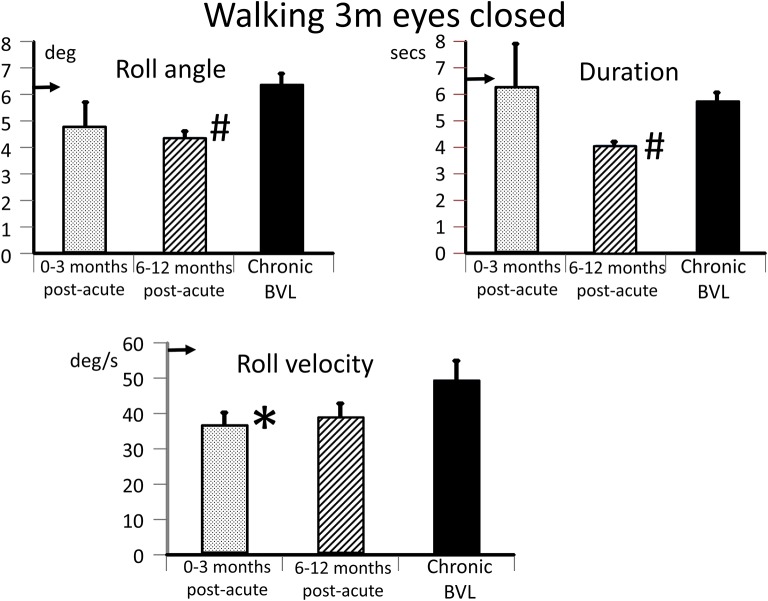
Measures of trunk balance control for the task, walking 3 m eyes closed. The layout of the figure is identical to that of Figure 3 (upper panels). The mean values of the acute BVL subject are compared to a population of 8 chronic BVL subjects and 54 normal control subjects (horizontal arrows on the ordinates). #p ≤ 0.002 and *p = 0.05.